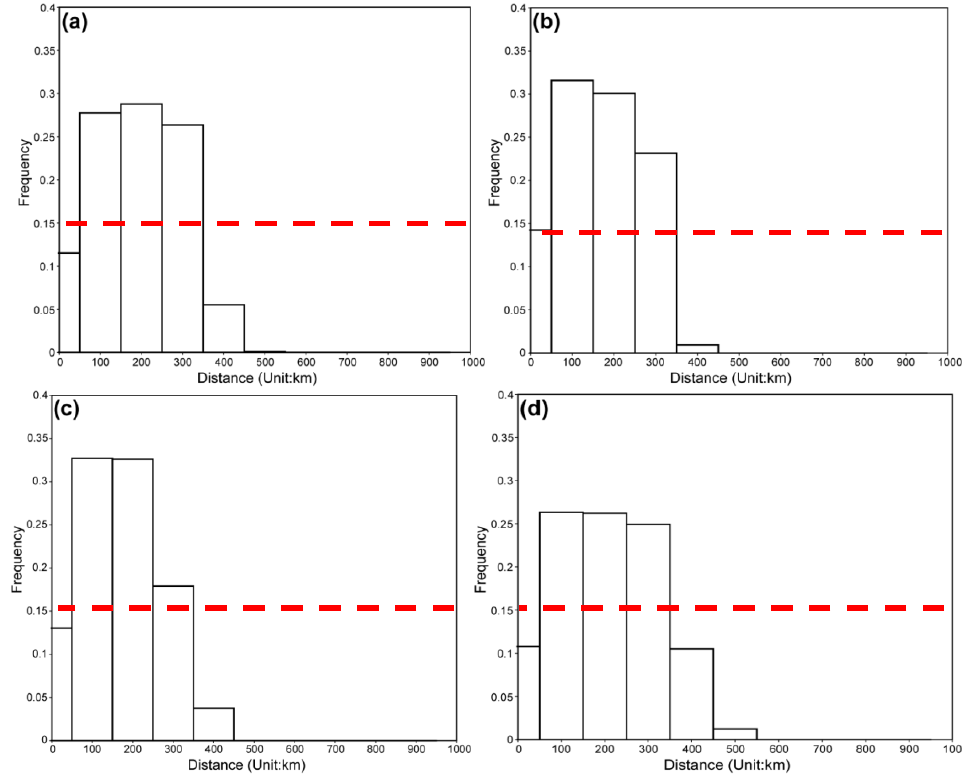
Figure 4 . Frequency distribution of distances between dry intrusions and jet axes at 340–355 K isentropic surfaces with 5 K interval (( a ) 34 K; ( b ) 345 K; ( c ) 350 K; ( d ) 355 K) (horizontal and vertical coordinate denote distance and frequency distribution correspondingly).